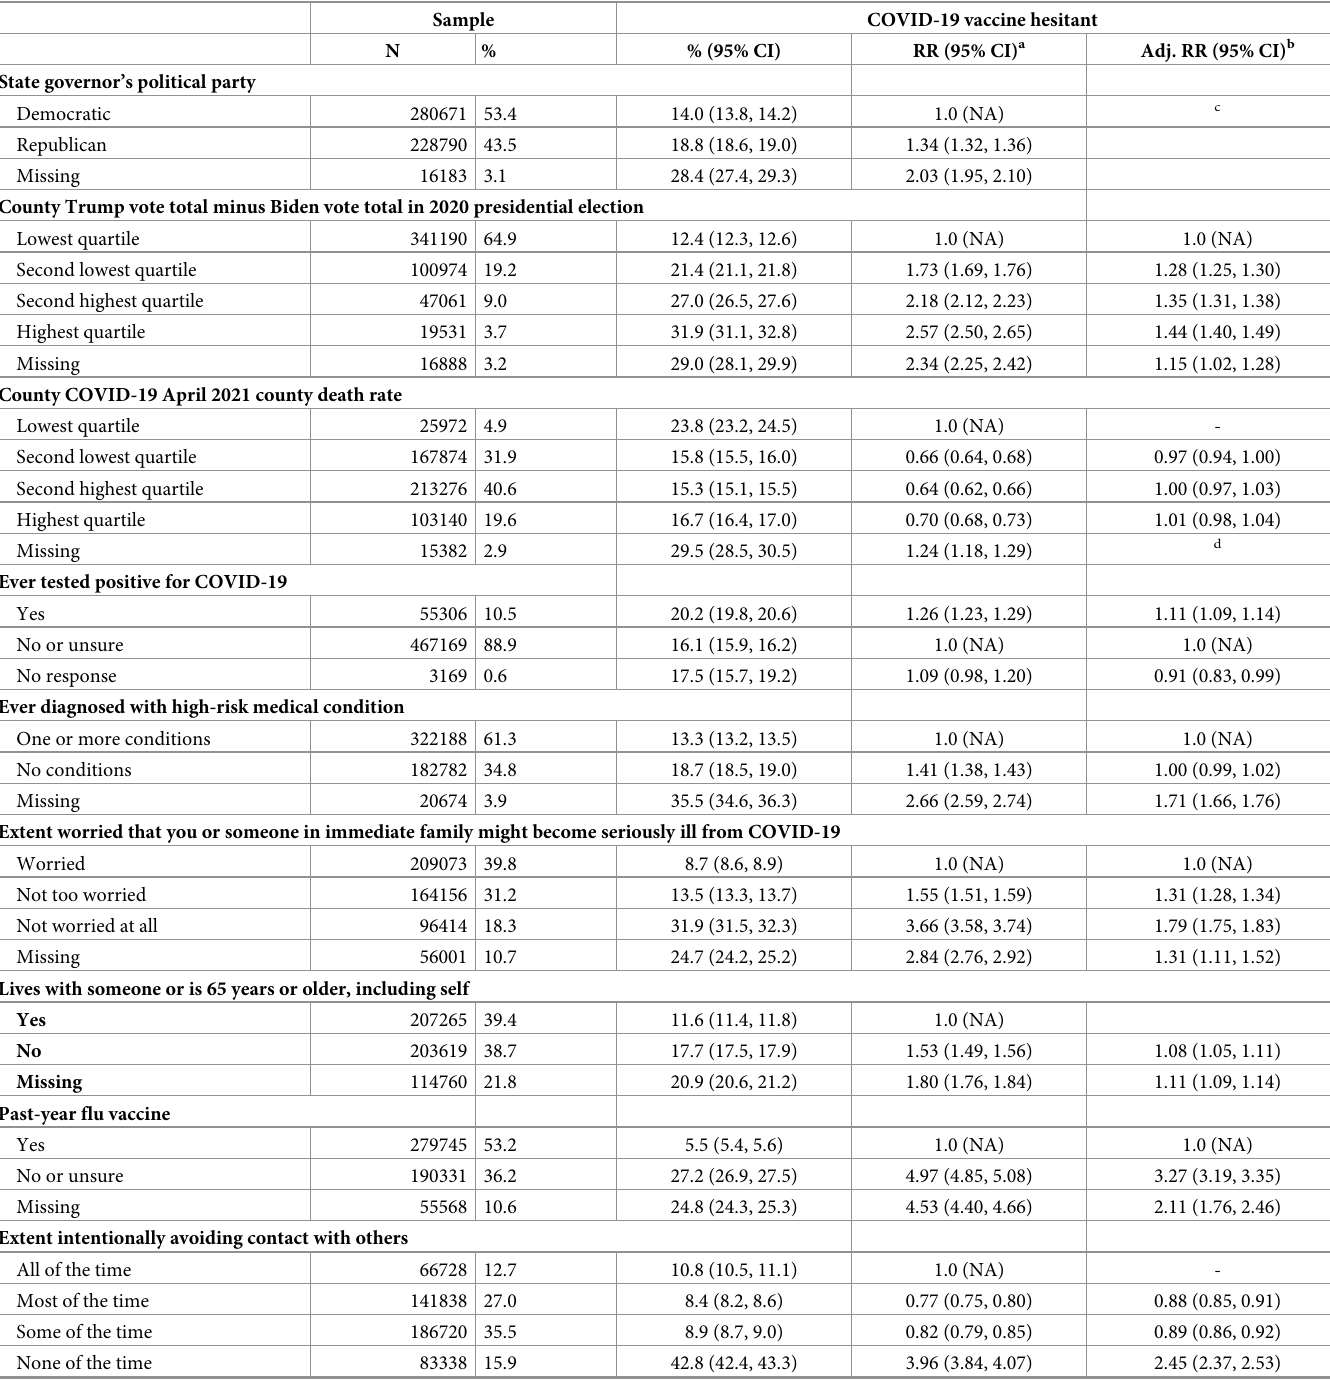
Table 2. COVID-19 vaccine hesitancy in May 2021 by political/ COVID-19 environment, health status, beliefs and behaviors among US adults (N = 525,644).